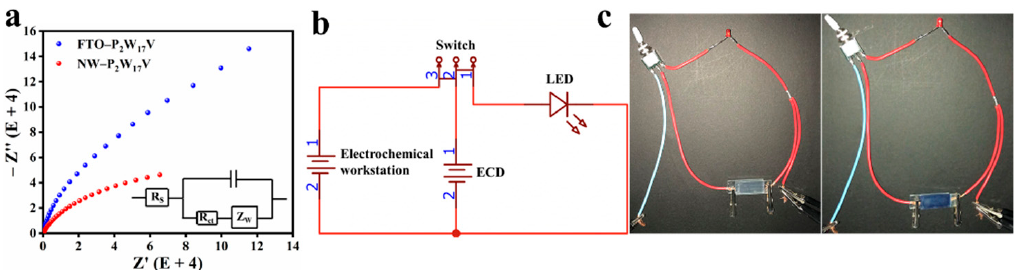
Figure 6. ( a ) The EIS figures of the films with different components FTO − P 2 W 17 V and NW − P 2 W 17 V film, the inset shows a simple equivalent circuit about the NW − P 2 W 17 V electrode system; ( b ) Structural diagram of the solid-state EC device architecture used in this work; ( c ) Photo of a red LED lit up and out by a solid-state EC device.